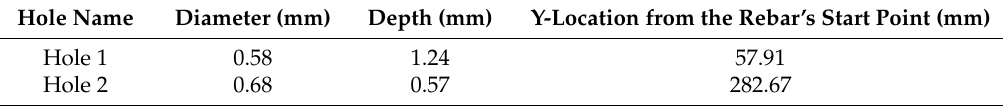
Table 1. Specifications of the two holes in the rebar.